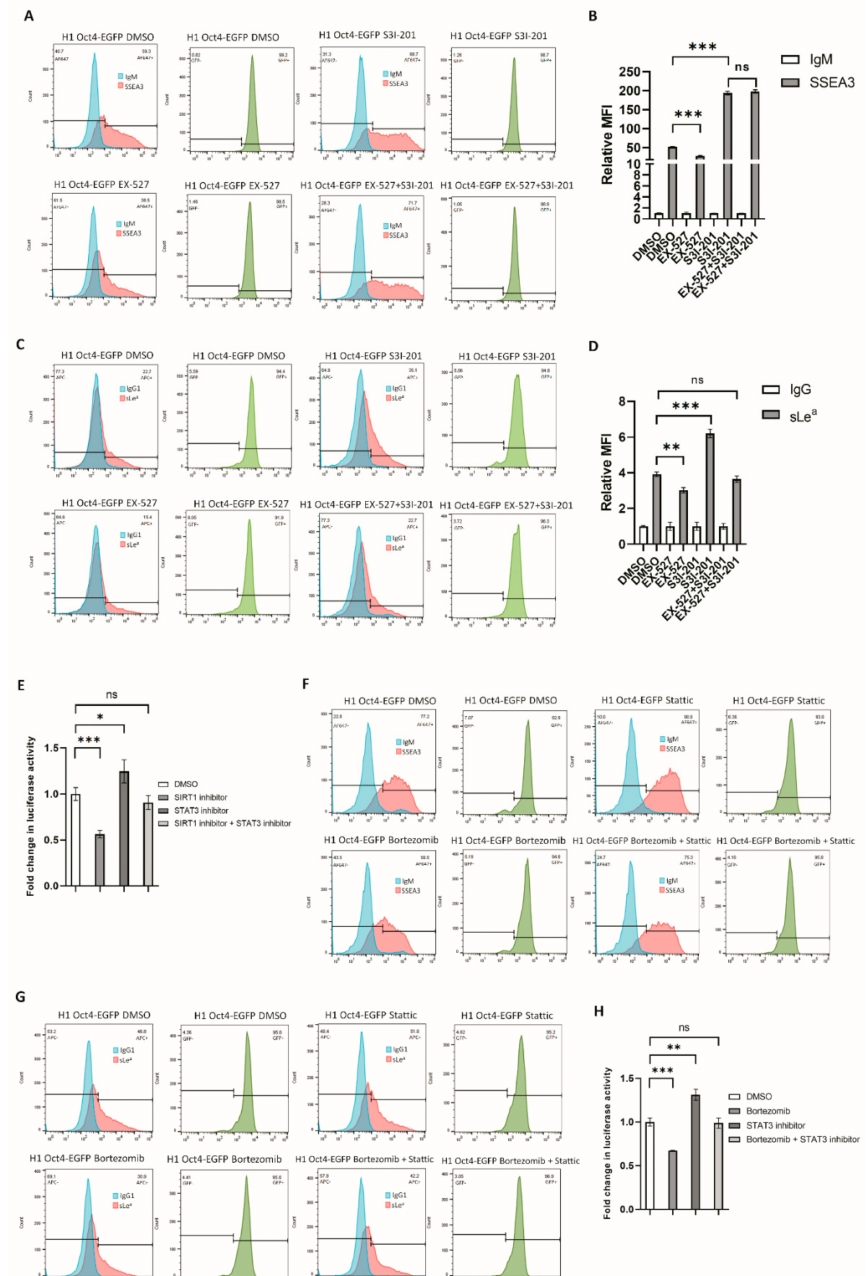
Figure 6. SSEA3 and sialyl Lewis a synthesis is altered by SIRT1 or STAT3 inhibitors. ( A ) Flow cytometry showing the levels of SSEA3 on H1 Oct4-EGFP cells after treatment with a SIRT1 or